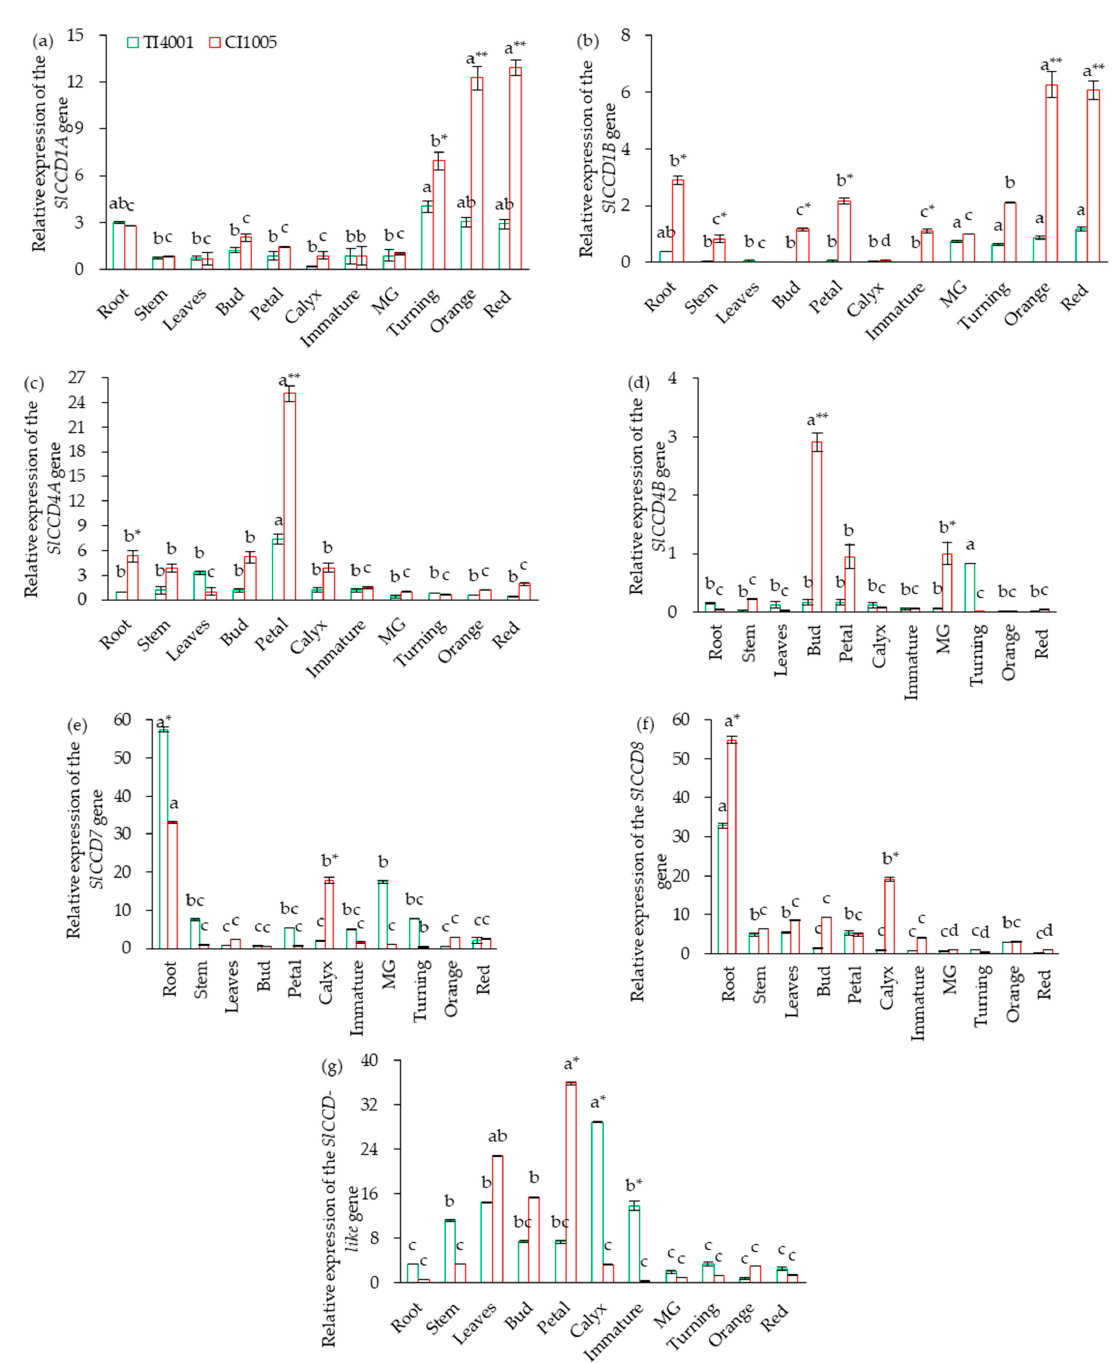
Figure 3. Expression of SlCCD s among different tissues of tomatoes. ( a – g ) The relative expression levels of the SlCCD1A , SlCCD1B , SlCCD4A , SlCCD4B , SlCCD7 , SlCCD8 , and SlCCD-LIKE genes. From left to right, the tissues were the root, stem, leaf, bud, petal, calyx, the immature green stage, the mature green stage, the turning stage, the orange stage, and the red stage. * Indicates a significant difference between TI4001 and CI1005 ( p < 0.05). ** Indicates a very significant difference between TI4001 and CI1005 ( p < 0.01). Lower case letters indicate significant differences in volatile contents among different tissues ( p <